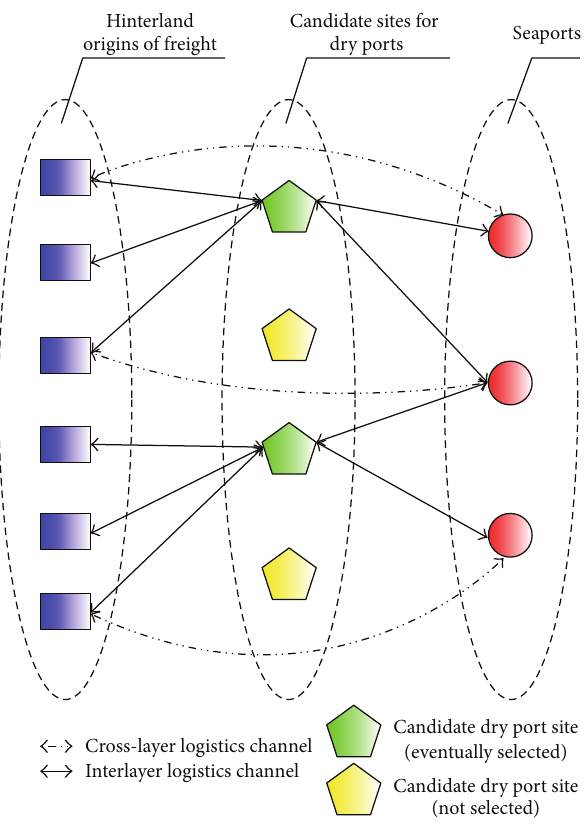
Figure 1: Network flow on a regional seaport-dry port